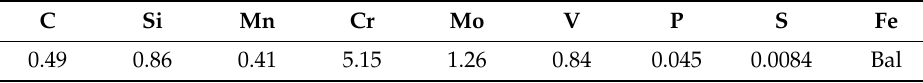
Table 1. Chemical composition of the H13-mod steel (wt